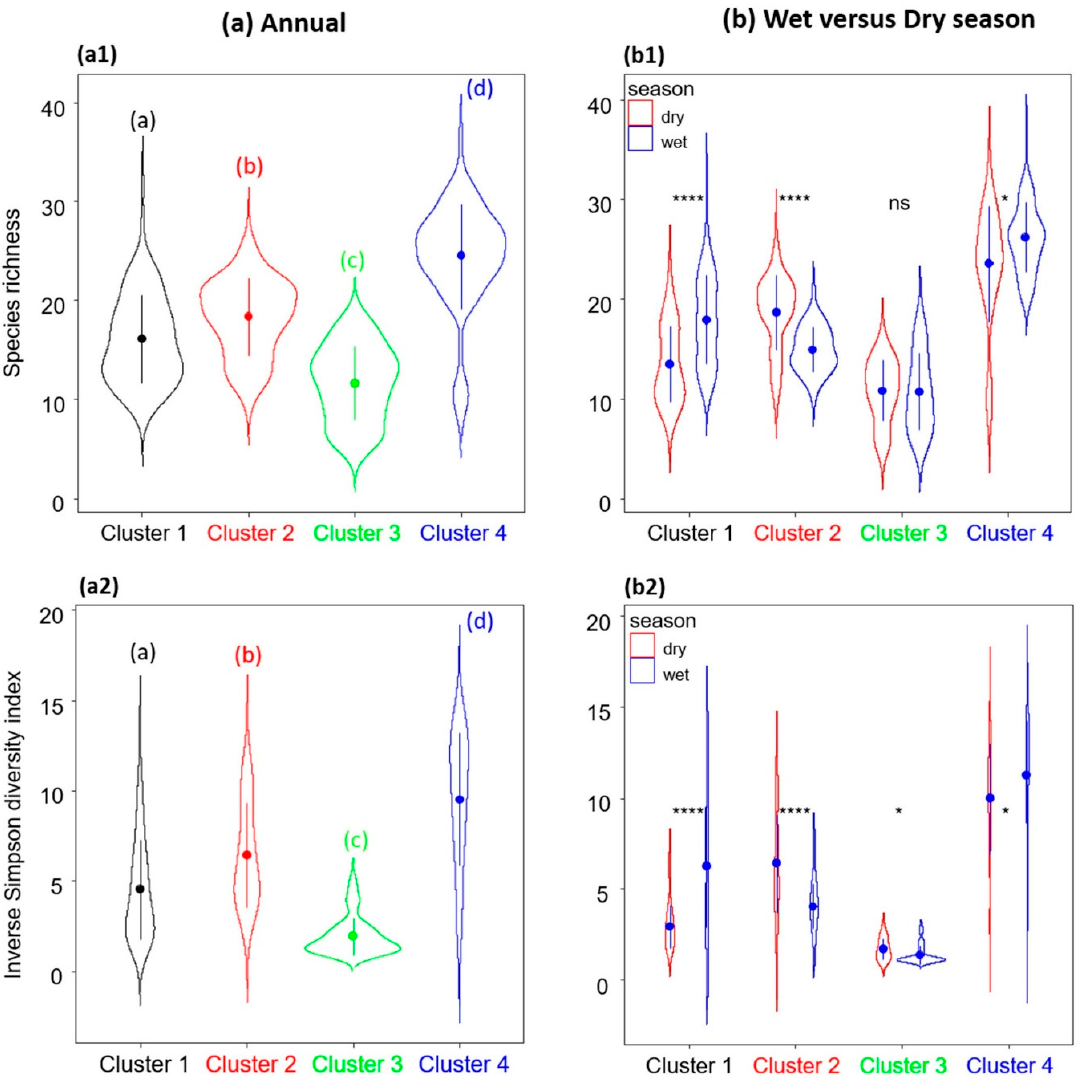
Figure 3. Violin plots showing fish species diversity based on weekly samples by cluster: ( a ) annual, ( b ) wet versus dry season. ( a1 , b1 ) show species richness, ( a2 , b2 ) inverse Simpson diversity indices. Clusters with a common letter are not significantly different at p = 0.05 (Pairwise Wilcoxon rank sum tests); sign (****) and (*) indicates significant differences at p < 0.001 and p ≤ 0.05, respectively between wet and dry seasons, and “ns” denotes “non-significance” (Kruskal–Wallis test). Points indicate the median of the data and (violin) boxes indicate the interquartile range.